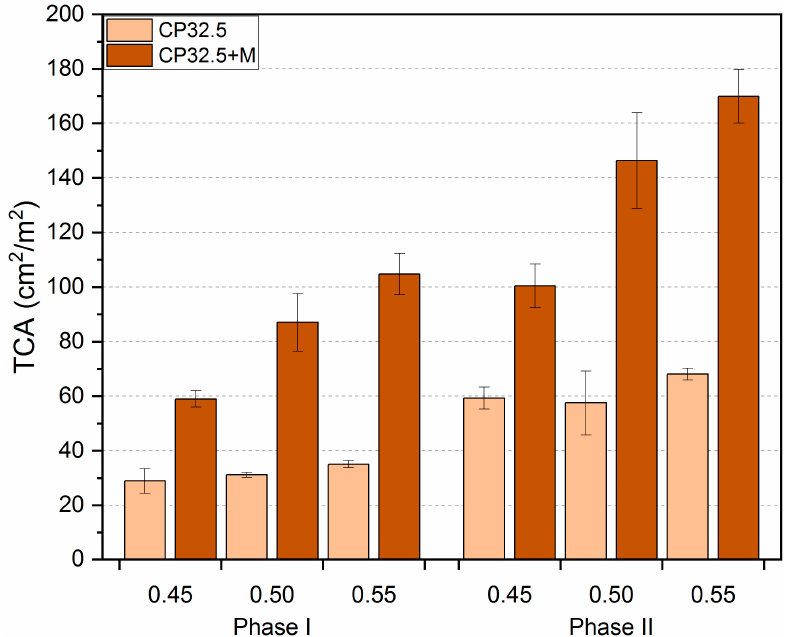
Figure 5. Results of the total crack area ( TCA ) of the lime cement matrix after the first and second phase of thermal load; error bars show standard deviation.